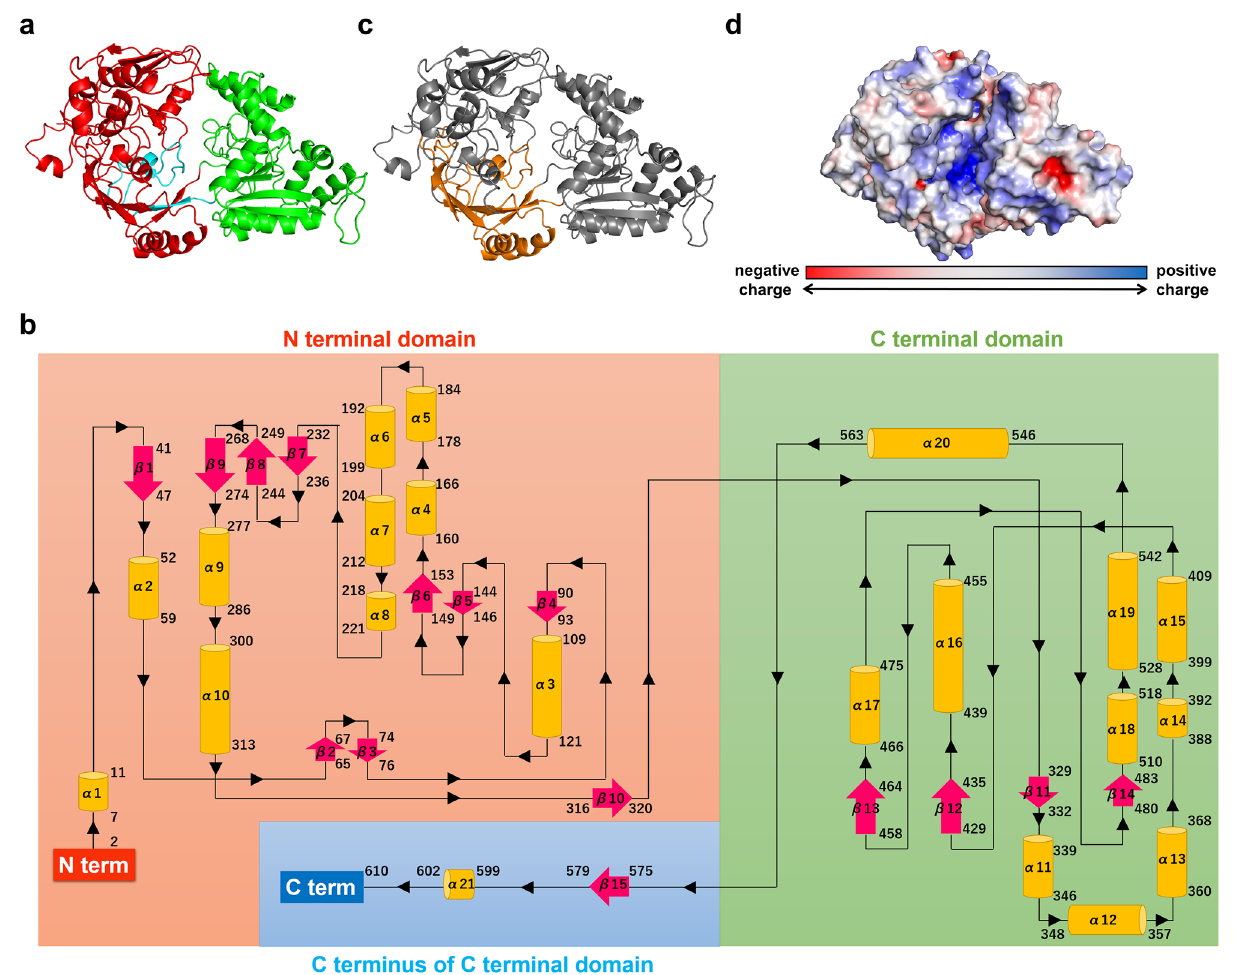
Figure 2. The crystal structure and surface charge of SPH1118. ( a ) Overall structure of substrate-free SPH1118 (open form). Red, N terminal domain (residues 2–322); green, C terminal domain (residues 323–572); cyan, C terminus of C terminal domain (residues 573–610). ( b ) Topology diagram of SPH1118. Orange, α-helix; magenta, β-strand; red, N terminal domain; green, C terminal domain; cyan, C terminus of C terminal domain. ( c ) The extra domain of SPH1118 (open form). Orange, extra domain (residues 41–47, 232–320, and 573–610); gray, other residues. ( d ) Surface charge profile of SPH1118 at pH 7.0. Blue and red surfaces refer to positively and negatively charged areas,